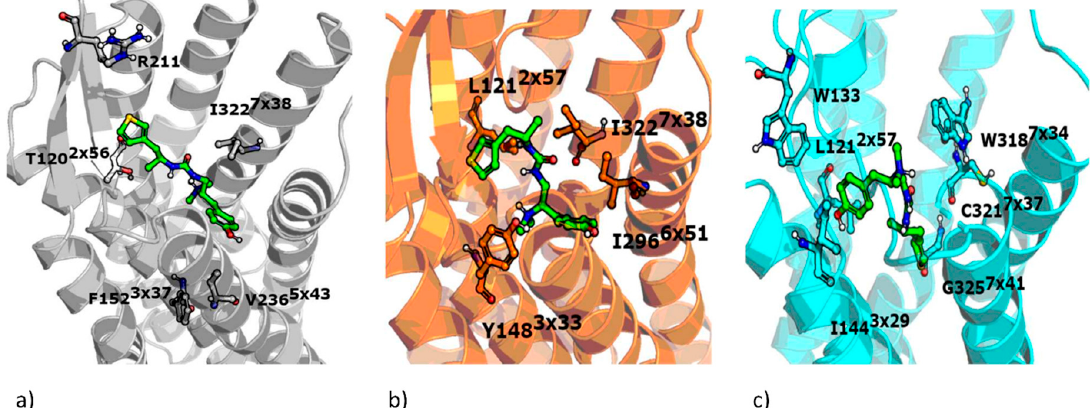
Figure 8. Residues with high correlation between the interaction frequency and experimental tests output obtained for ( a ) 4DKL, ( b ) 5C1M, and ( c ) 6DDF. PZM21 visualized for reference.